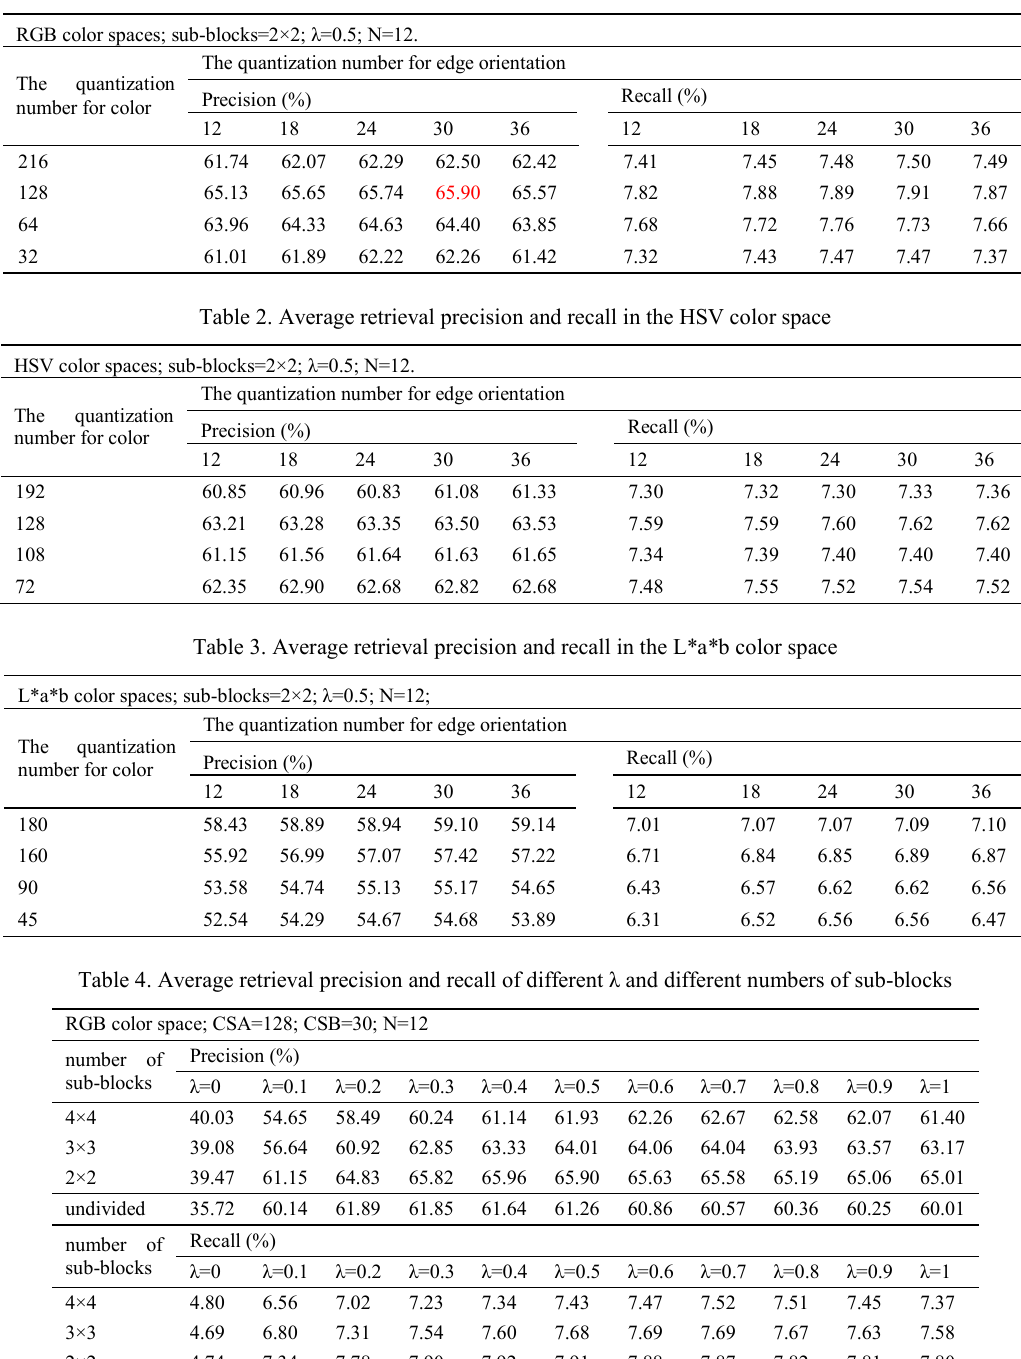
Table 1. Average retrieval precision and recall in the RGB color space